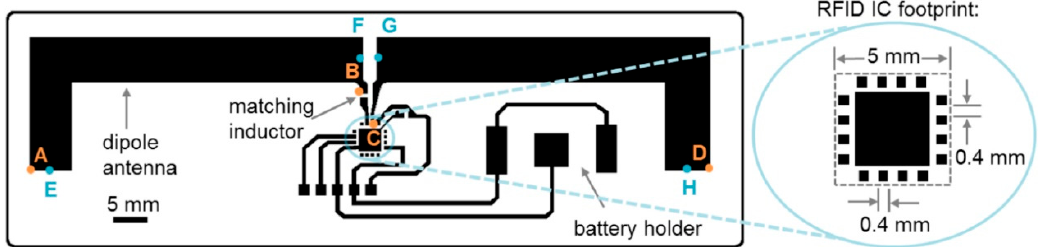
Figure 7. Tag design (110 mm × 35 mm) based on a development kit for printing onto different substrates. A to B and C to D show the longest path over which resistance measurements are made for each antenna arm, while E to F and G to H show the centre paths over which resistance is measured. (Re-printed from Smith et al. [86]. Copyright (2018), with permission from IOP Publishing Ltd.).